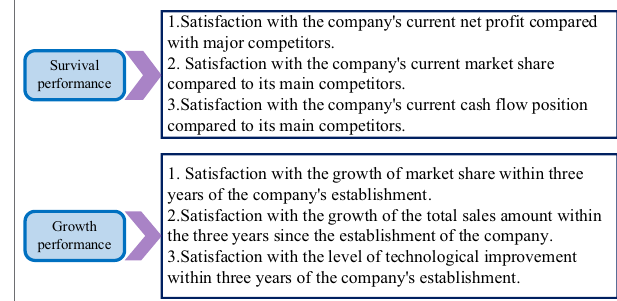
FIGURE 6 | Enterprise innovation performance